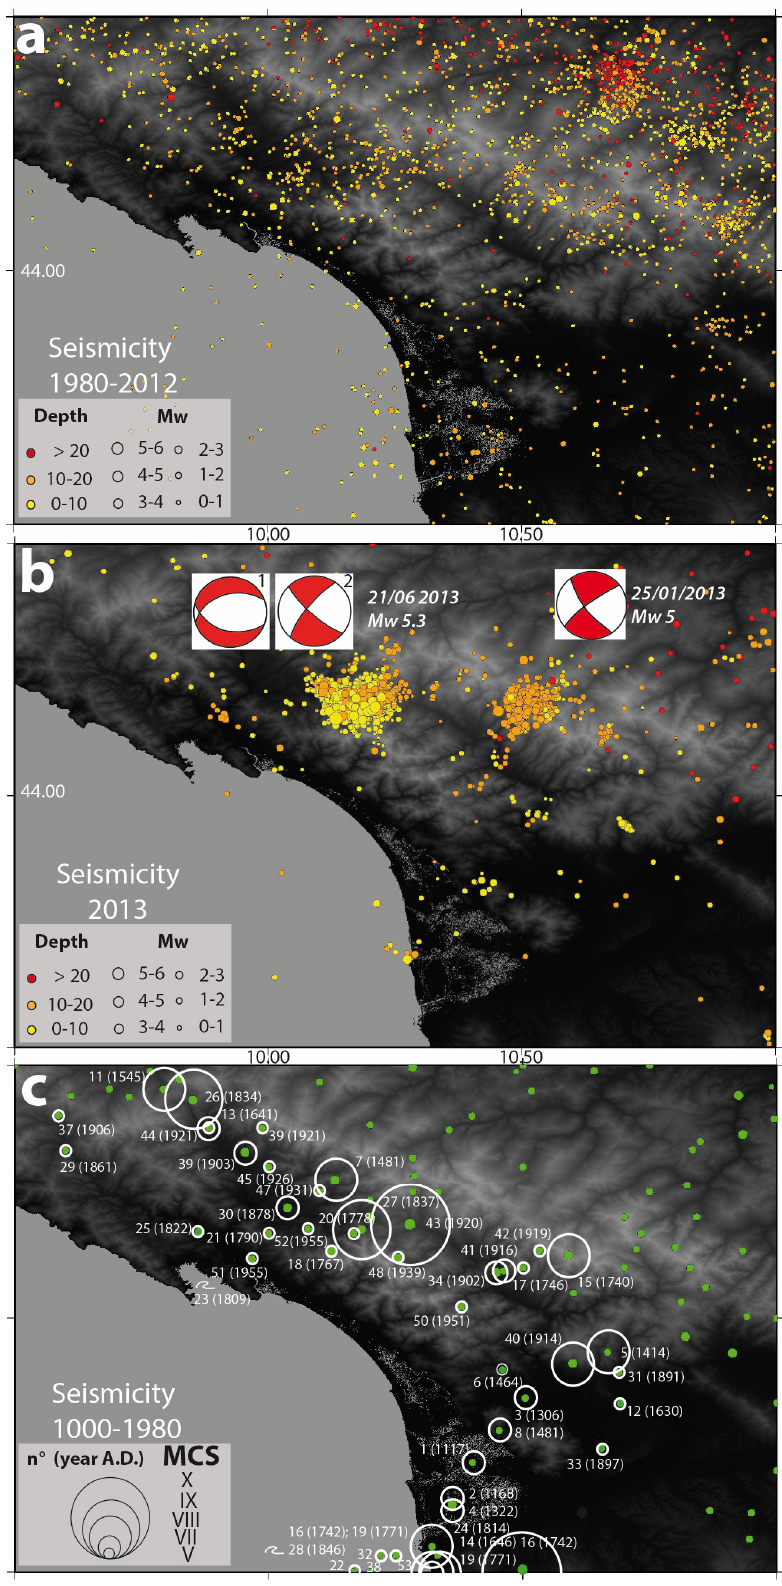
Figure 12. Seismicity in the studied area (instrumental and historical). ( a ) 1982–2012; ( b ) 2013; ( c ) historical moderate to large earthquakes (intensities greater than V) reported from 1000 to 1980 (from CPTI15-DBMI15 catalogs). Identification numbers are the same as those reported in Table S2.